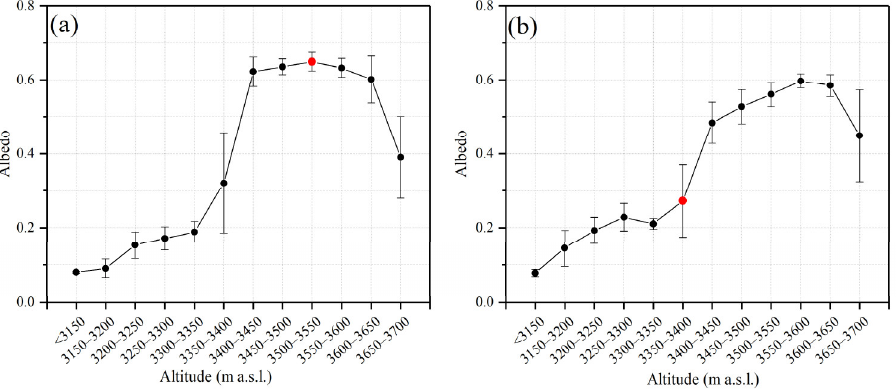
Figure 5. The average albedo variation of the 50 m altitude intervals along the glacier main flowline in ( a ) 2019, ( b ) 2015, respectively.